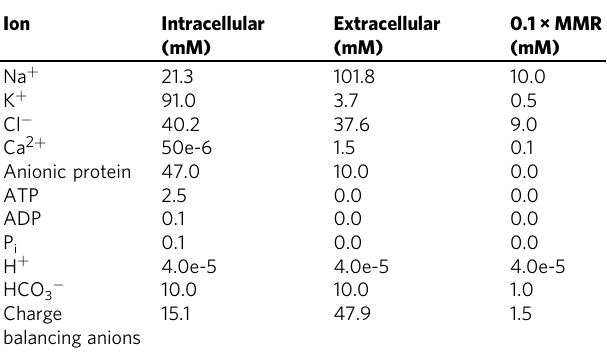
Table 1 Initial simulation concentrations in the intracellular space (cytosol), extracellular space (intercellular regions), and global environmental space surrounding cells (0.1 ×